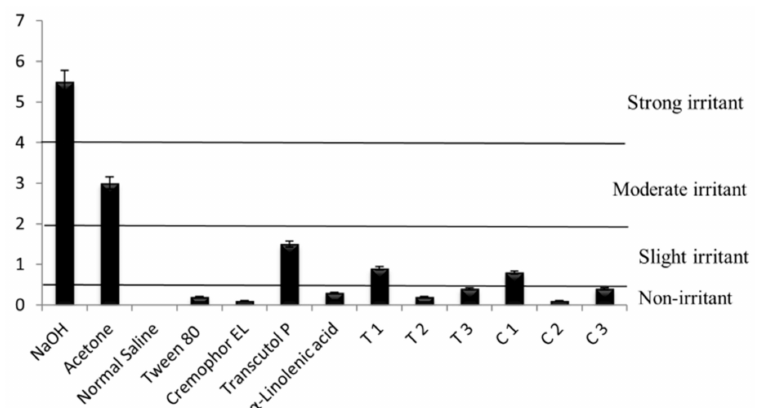
Figure 7. Cumulative BCOP scores of NaOH (strong positive control), Acetone (moderate positive control), Normal Saline (negative control), Tween 80, Cremophor EL, Transcutol P, and the microemulsion formulations; T1, T2, T3 and C1, C2 and C3. Results are expressed as mean values ± SD, n = 3.